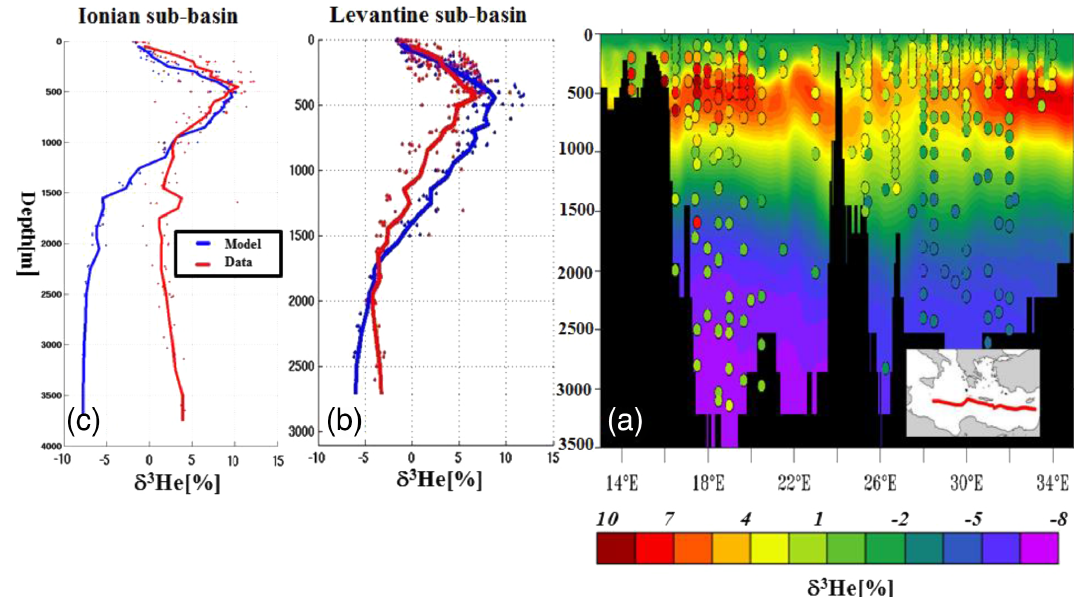
Figure 7. Total δ 3 He (sum of terrigenic, tritiugenic and atmospheric helium) model–data comparison along the Meteor M5 (September 1987) section. (a) Colour-filled contours indicate simulated δ 3 He (%), whereas colour-filled dots represent in situ observations. (b) and (c) : com- parison of average vertical profiles for the Levantine and Ionian sub-basins, respectively; model results are in blue; red indicates in situ data. Table 3. Helium inventory (in mole) in the Mediterranean Sea. Helium-3 % (terrigenic) Helium-4 % (terrigenic)